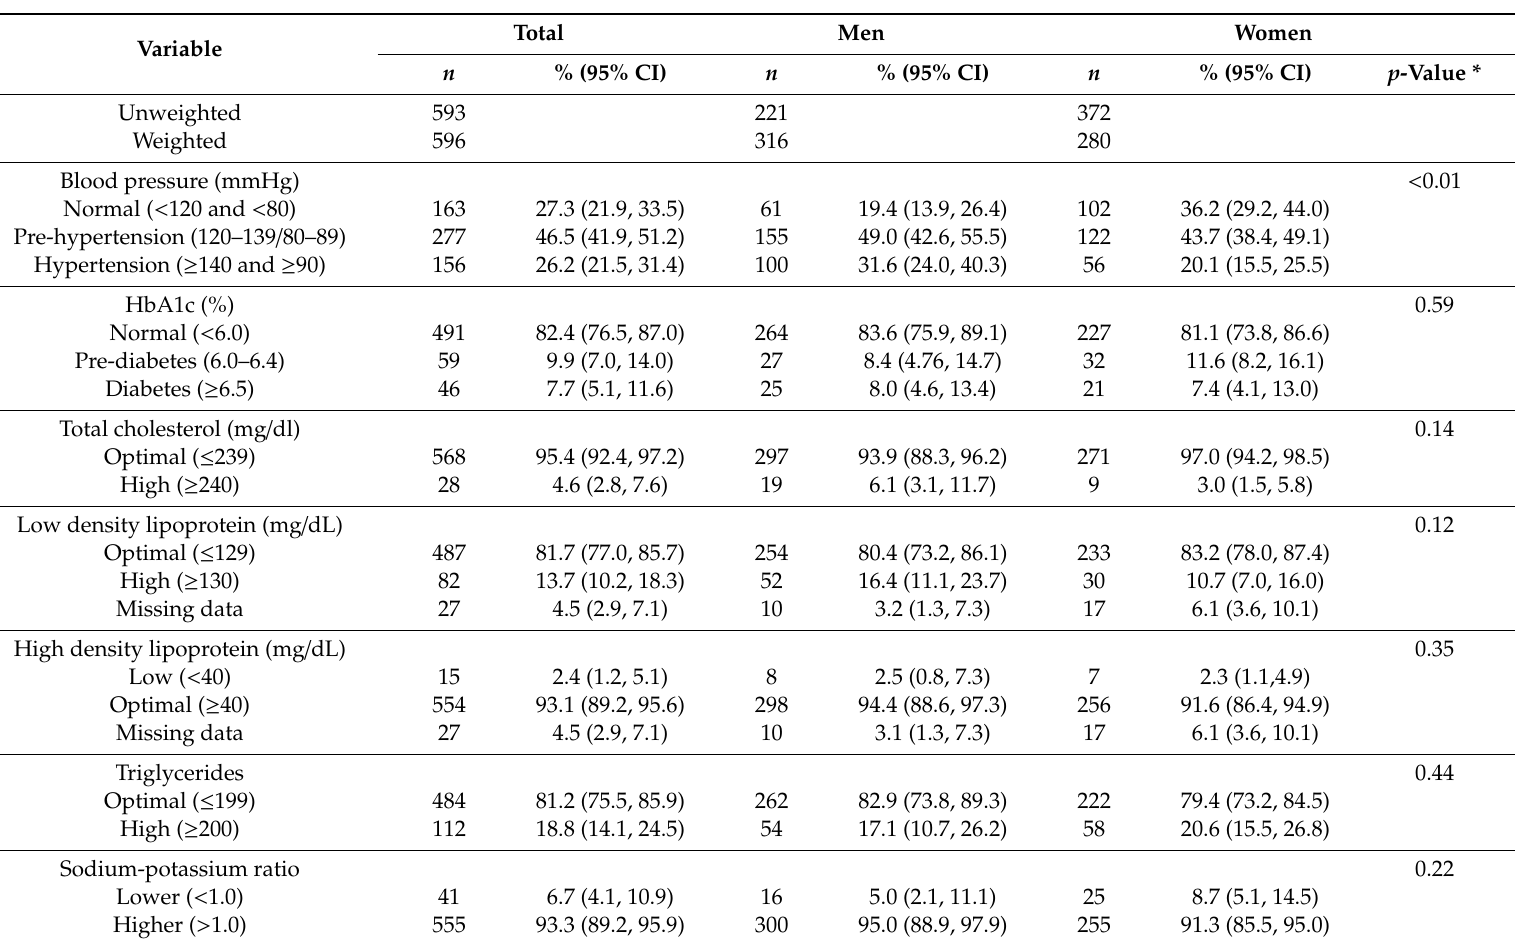
Table 2. Prevalence of cardio-metabolic risk factors of non-communicable diseases (NCDs **) by sex among the residents of Kajiado County, Kenya ( n = 593).